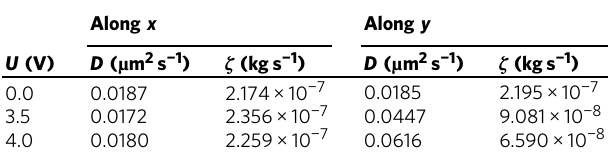
Table 2 Lateral diffusivity D and effective viscous drag coef fi cients ζ of skyrmions Along x Along